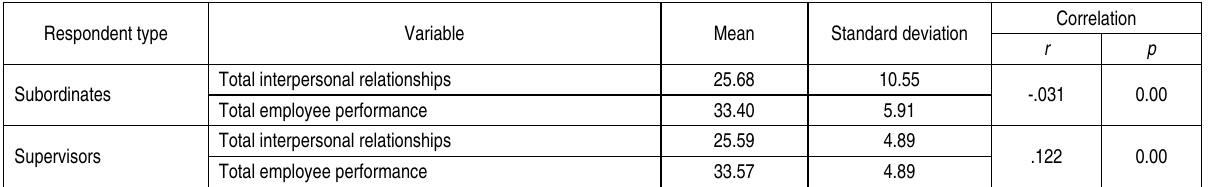
Table 2. Correlation matrix for supervisors’ and subordinates’ interpersonal relationships and employee